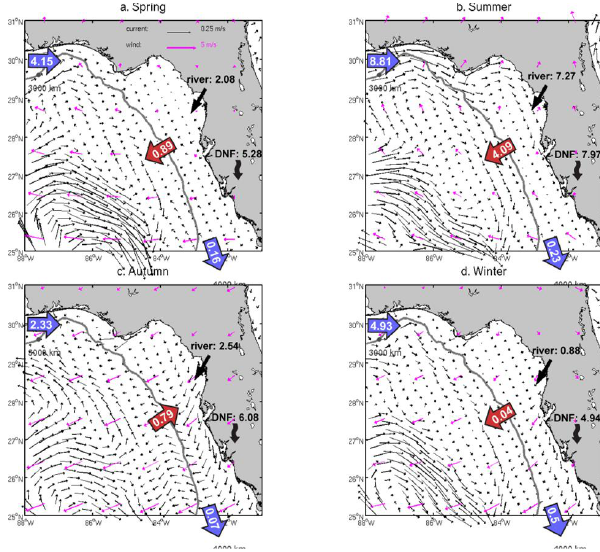
Fig. 16. Similar to Fig. 13 but for the West Florida